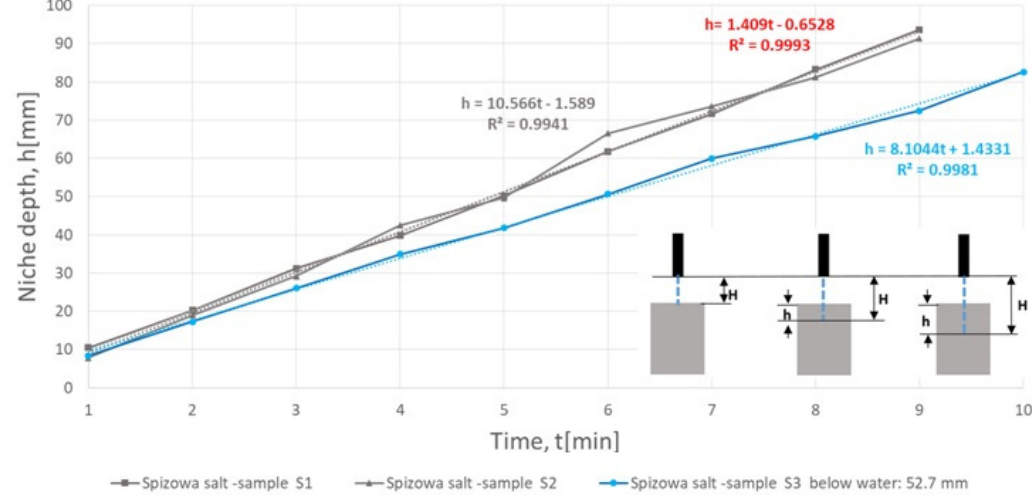
Figure 9. Average depth of cut niche as a function of water cutting time—Spiza salt. Nozzle’s displacement velocity v = 100 (mm/min). Water jet pressure p = 500 bar.